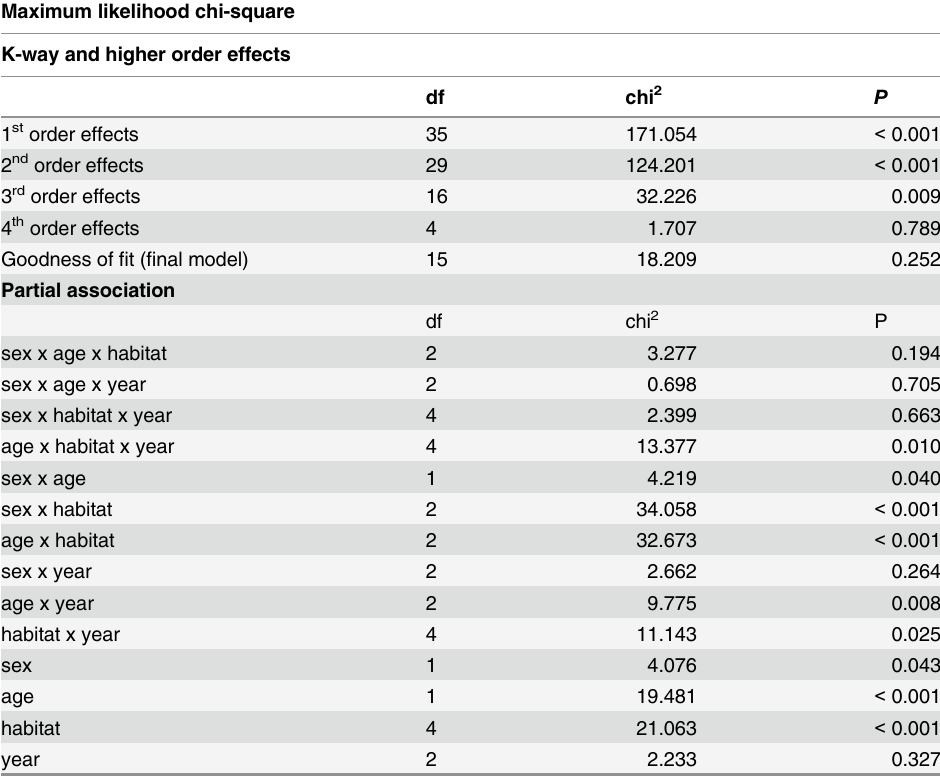
Table 1. Results of the hierarchical log-linear analysis for age and sex composition in different habi- tats and years. Maximum likelihood